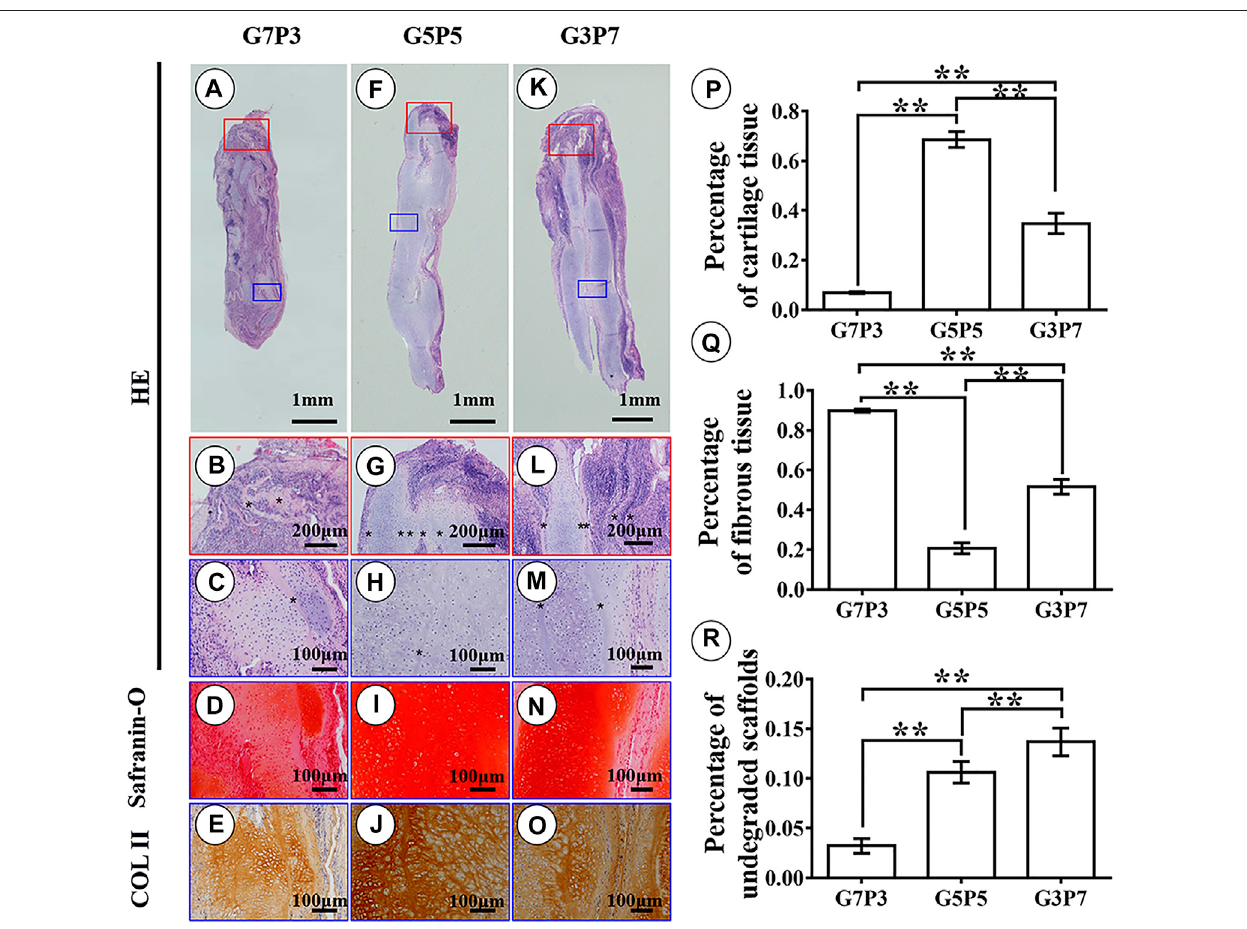
FIGURE 6 | Histological examination and semiquantitative analysis in engineered tissues at 6 weeks in vivo . Histological evaluation shows that the samples in the G7P3groupformcartilageislandsisolatedby fi broustissueanddiscontinuouslamellarscaffolds (A – E) whilethesamplesintheG5P5andG3P7groupsformcontinuous and homogenous cartilage with continuous undegraded lamellar scaffolds in the interior area ofthe samples (H – J,M – O) . The edge regions in the G5P5 group (G) show relatively satisfactory cartilage integration with little fi brous tissue invasion while the edge regions in the G3P7 group present relatively inferior tissue integration (separated by undegraded lamellar scaffolds *) with obvious fi brous tissue invasion (L) . The semiquantitative analysis shows signi fi cant differences in area percentage of cartilage tissue, fi brous tissue, and undegraded scaffolds among the three groups (P – R) .